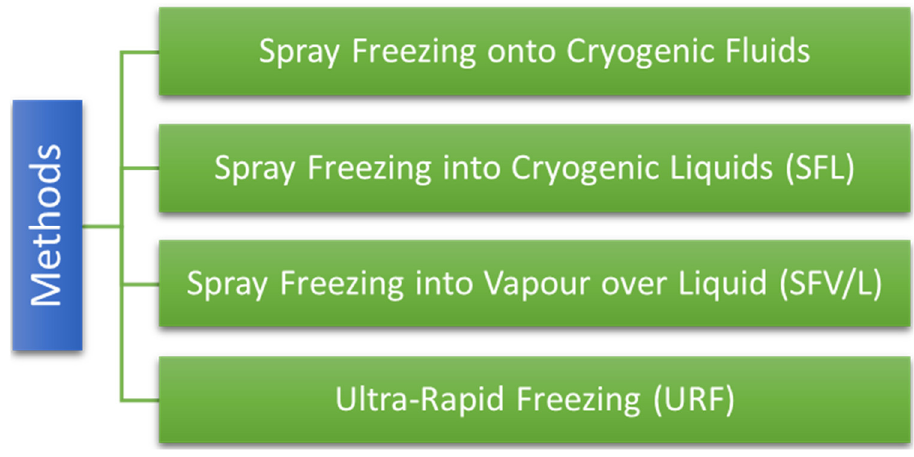
Figure 5. Various cryogenic methods.